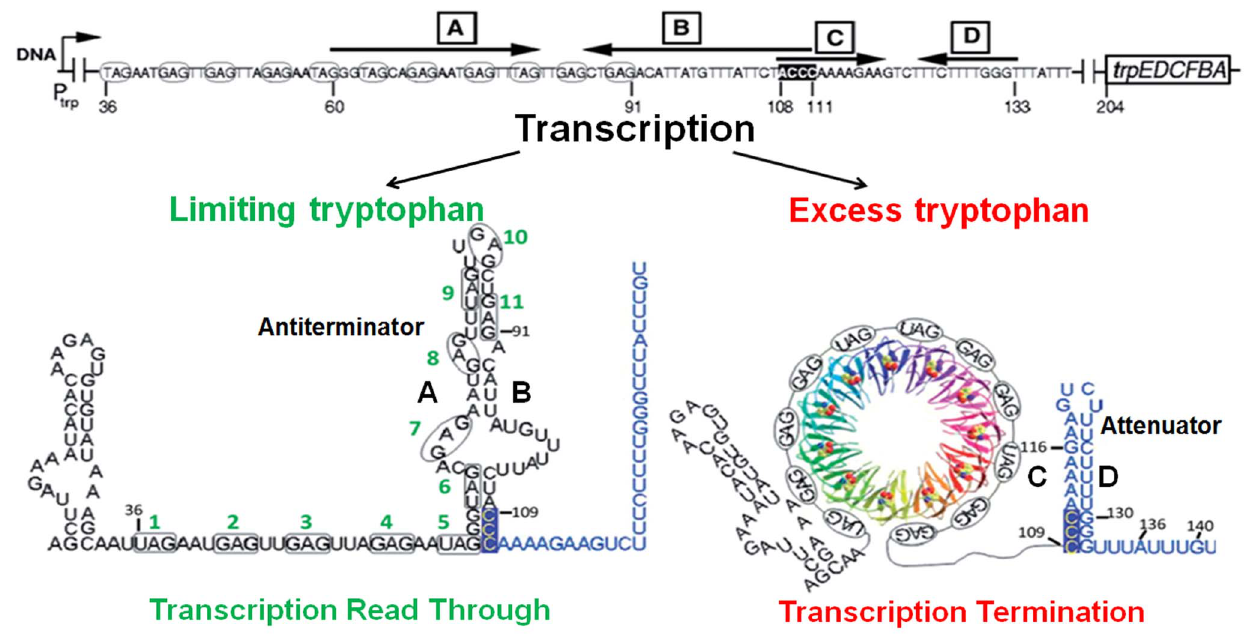
Figure 1. Model of transcription attenuation of the B.subtilistrp operon. Bold black letters designate the complementary strands of the attenuator (C/D) (highlighted in blue) and antiterminator (A/B) RNA structures. TRAP is shown in a ribbon diagram with each subunit in a different color. The 11 (G/U)AG repeats of the TRAP binding site are circled and numbered in green. Small black numbers indicate RNA residues relative to the start of transcription. When tryptophan is limiting, the AB antiterminator RNA structure forms, allowing read through of the trp operon. In excess tryptophan, TRAP binds to the nascent RNA and prevents formation of the antiterminator structure, which allows formation of the attenuator, leading to transcription